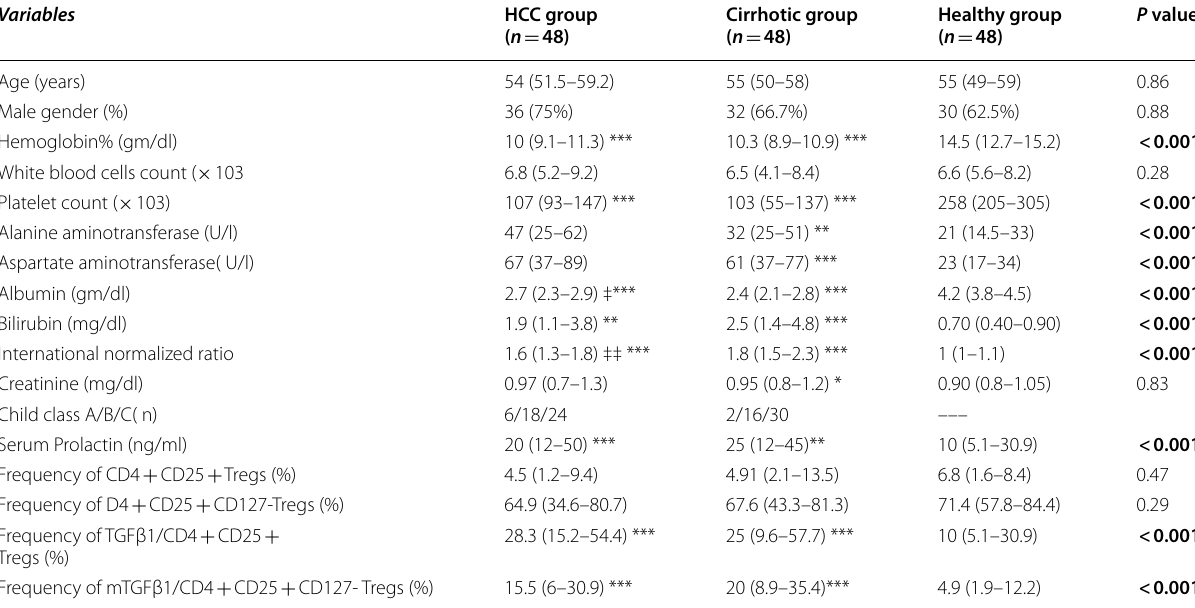
Table 1 Demographic, laboratory, and flow cytometric data of the studied